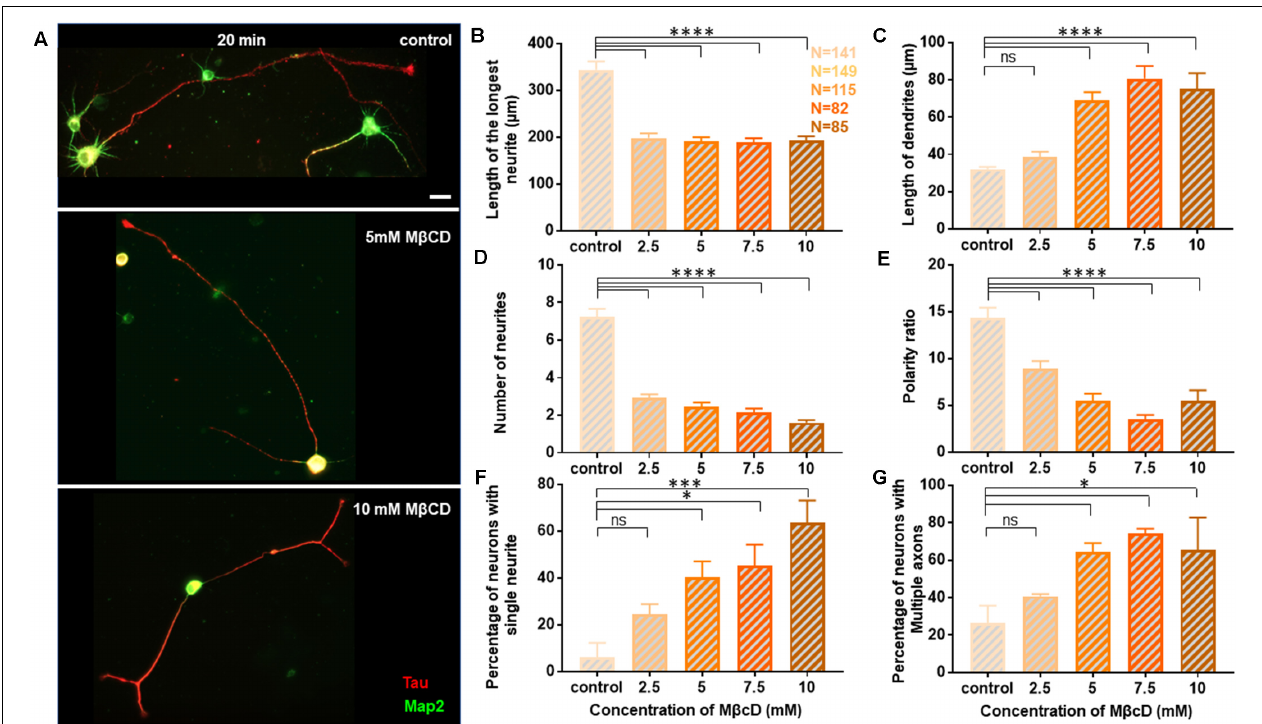
FIGURE 4 | Neuronal developmental defects in growth and polarity are retained independent of the duration of transient cholesterol perturbation. Neurons at DIV1 were transiently treated with varying concentrations of M β CD for 20 min to sequester cholesterol. The cells were labeled with Tau (red) and Map2 (green) and imaged at DIV3. (A) A gallery of control and cells treated with varying concentrations of M β CD for 20 min is presented. (B–E) Represents the length of the longest neurite (B) , length of dendrites (C) , number of neurites in each cell (D) , and the polarity ratio (E) at varying concentrations of M β CD. (F,G) Represents the percentage of treated neurons displaying single neurites (F) and supernumerary axons (G) , respectively. Cholesterol sequestration for a longer duration resulted in neurons displaying significant defects in axonal growth but complementing dendritic growth, similar to shorter perturbation. Consistent with acute transient perturbation, longer cholesterol sequestration also resulted in neurons displaying single neurites and multiple axons, exhibiting a severe shift in neuronal polarity. N denotes the number of cells from three independent cultures. One-way Anova was performed to test the significance of the difference between the means. ∗∗∗∗ p < 0.0001, ∗∗∗ p < 0.001, ∗ p < 0.05 and ns non-significant. Scale bar indicates 20 µ